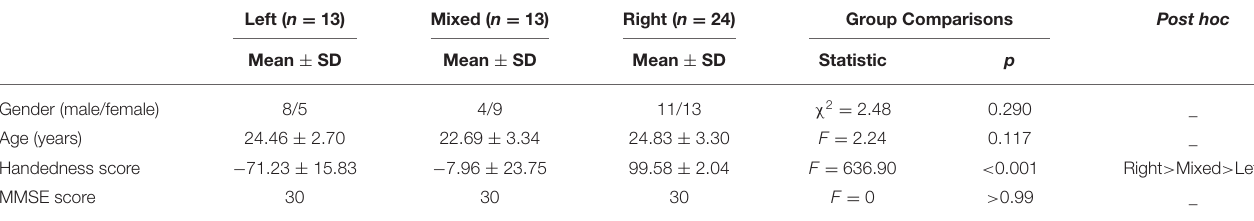
TABLE 1 | Summary of the demographic and questionnaire